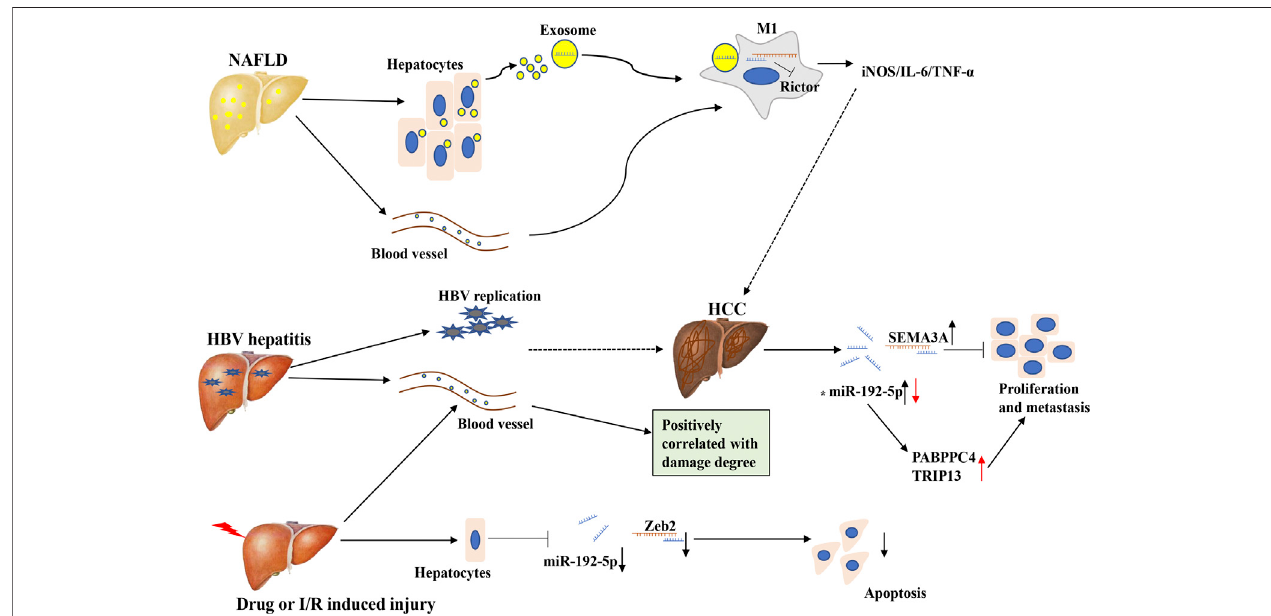
FIGURE 4 | The expression and regulatory mechanism of miR-192-5p in different liver diseases. In NAFLD, miR-192-5p is increased in serum exosome, and exosomal miR-192-5p derived from hepatocytes promote the polarization of in fl ammatory macrophage. In HBV hepatitis, drug or I/R induced liver jury, circulating miR- 192-5p isincreased, which can target different molecules. In HCC, the expression ofmiR-192-5p iscontroversial. Full line representswhat actually happens, dotted line represents what might happen. The asterisk (*) represents the controversial role of miR-192-5p.